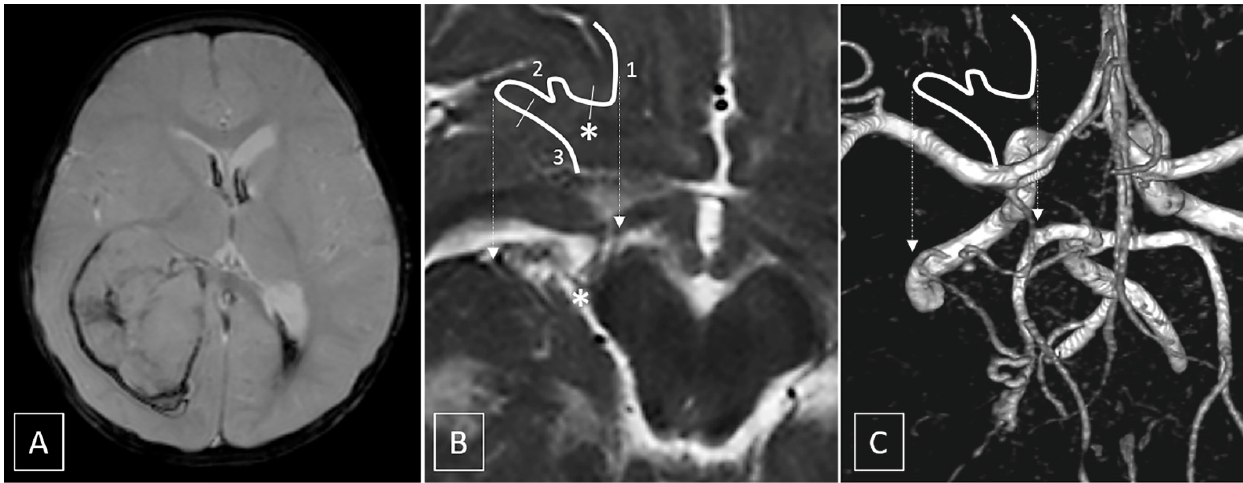
Figure 1. ( A ) Gradient-echo image shows intralesional, perilesional and intraventricular hemorrhagic components. ( B , C ) T2 axial ( B ) and Volume Rendering of ToF MRA ( C ) show the course of the anterior choroidal artery. The shifted white line represents, schematically, the course of the artery; dashed arrows indicate the exact location of the highlighted vessel. Segment 1 is the cisternal portion of the artery which courses across the carotid, crural and ambient cysterns, up to the choroidal fissure, where it enters the ventricle; the asterisk * corresponds to the plexal point that marks the entrance in the ventricle, and segment 2 is the intraventricular segment. Segment 3 is the tumoral segment of the artery running along the surface of the tumor (see Figure 4 for the complete anatomical description).